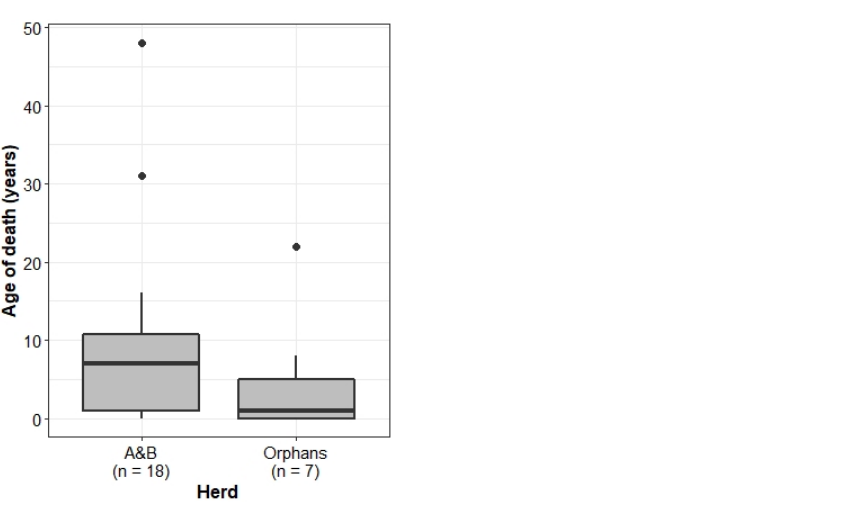
Figure 2. Age of death of individuals in the A&B herd and Orphans. Boxplots show median, IQR, and outliers. Numbers on the x -axis indicate the number of deaths recorded in each herd. Of these infant mortalities, the Orphans lost more infants to the train (n = 2, accounting for 40% of infant mortalities) than the A&B herd (n = 1, 14% of infant mortalities), but the A&B herd additionally lost three infants to drowning (accounting for 43% of infant mortalities).